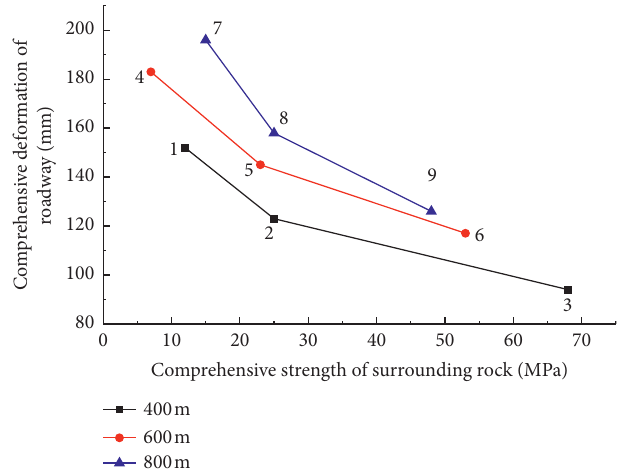
Figure 13: Deformation of each monitoring